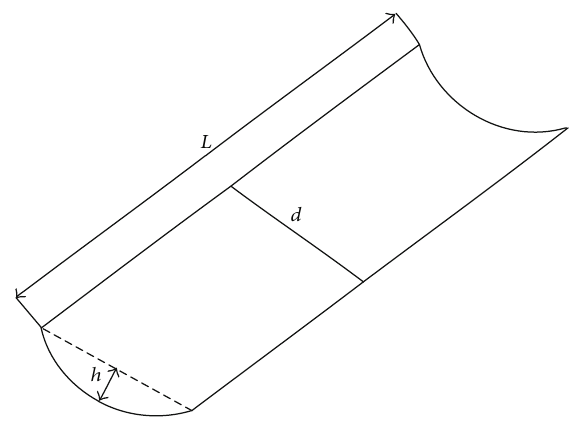
Figure 3: Schematic view of the secondary re fl ector.